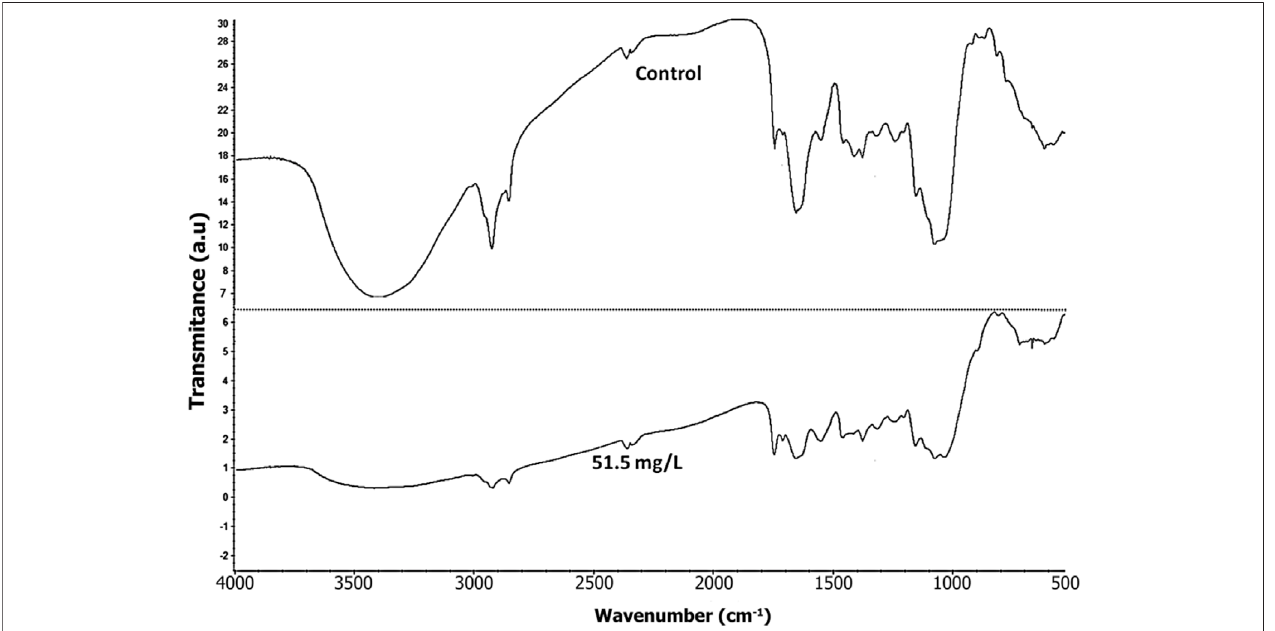
FIGURE 6 | FT-IR of Penicillium sp . biomass before treatment (control) and after treatment with 51.5 mg L − 1 of Pb (II), Cd (II), and Hg (II).